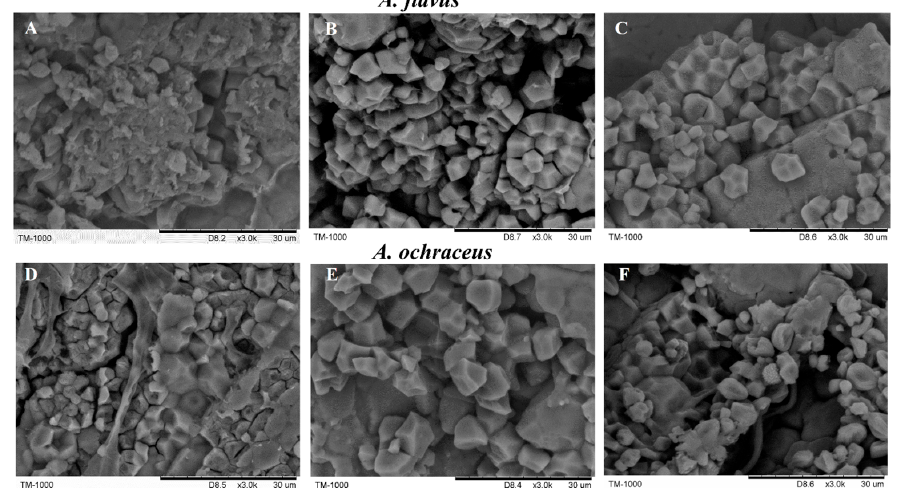
Figure 2. The SEM images of surface morphologies of rice with geraniol and citral treatments after 8 d of exposure to Aspergillus spp. ( A ) A. flavus ; ( B ) A. flavus treated with geraniol; ( C ) A. flavus treated with citral; ( D ) A. ochraceus ; ( E ) A. ochraceus treated with geraniol; and ( F ) A. ochraceus treated with citral.